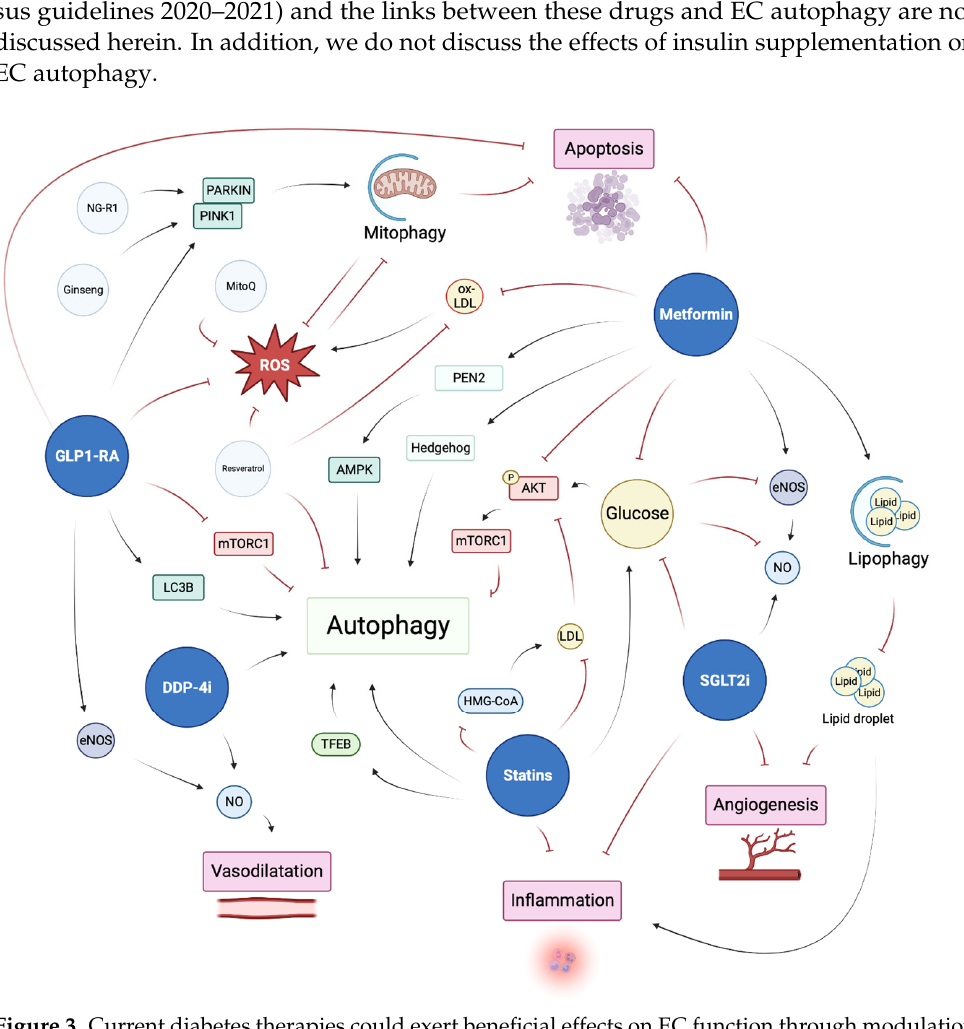
Figure 3. Current diabetes therapies could exert beneficial effects on EC function through modulation of EC autophagy. (Created with Biorender: https://biorender.com accessed on 10 January 2023).